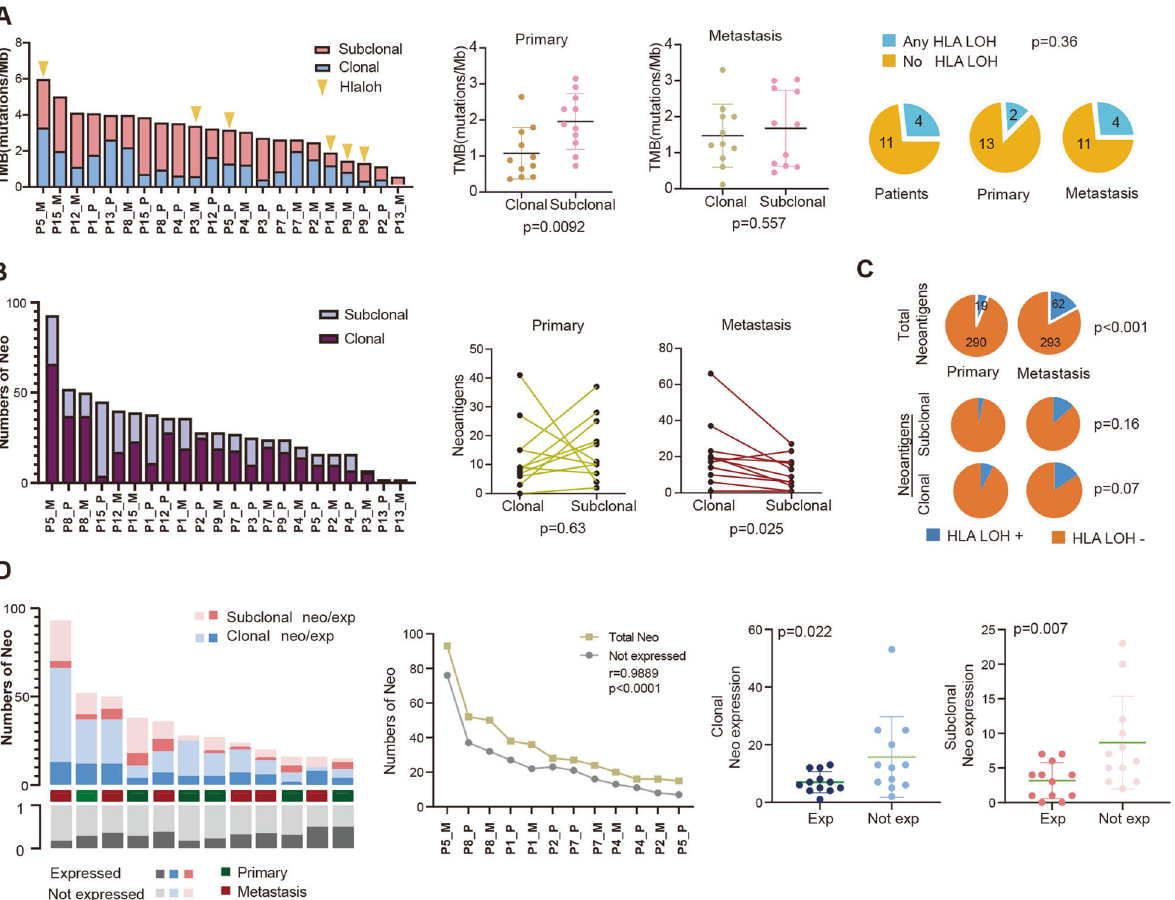
Fig. 5 HLALOH-related TMB and neoantigens in CLM. A The distribution of mutation clonality and HLA LOH events. B The distribution of neoantigens clonality. C The distribution of HLALOH events in total neoantigens, clonal neoantigens and subcloanal neoantigens. D Neoantigen depletion in transcriptional level. Top, the clonal and subclonal expressed (exp) neoantigens (neo) in each patient. Bottom, the fraction of clonal neoantigens that are ubiquitously expressed. Correlation analysis between the counts of neoantigens and non-expressed neoantigens (middle panel). The counts of clonal or subclonal neoantigen depletion (right two panels). TMB Tumor mutation burden, HLA Human leukocytes antigens, LOH Loss of heterozygosity.